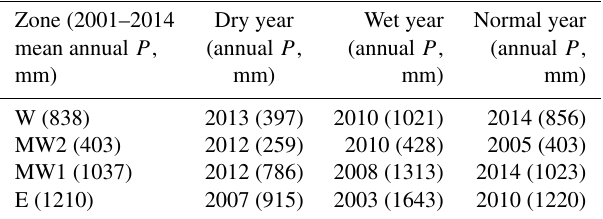
Table 4. Study years considered for regional-scale intercomparison of annual ETs from STIC1.2, SEBS, and